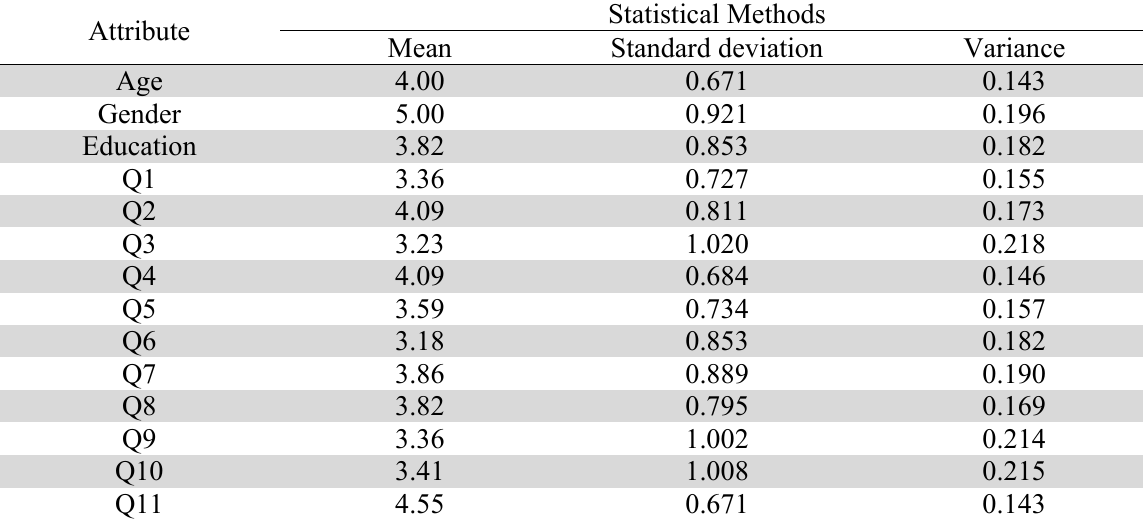
Statistical analysis of data set